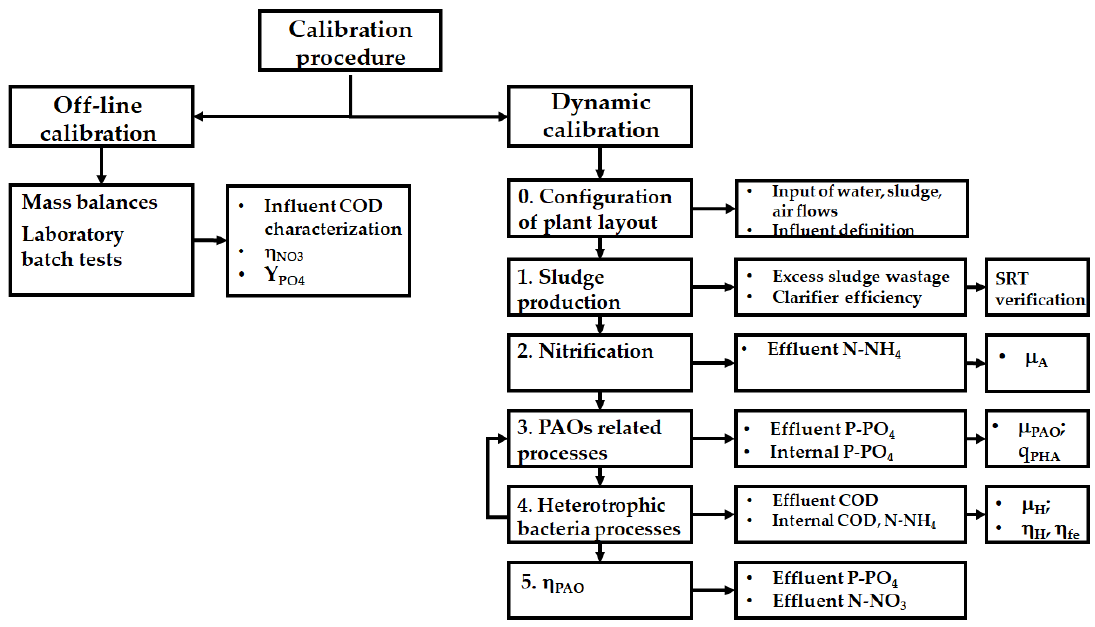
Figure 1. S chematic presentation of calibration procedure. Figure 1. Schematic presentation of calibration